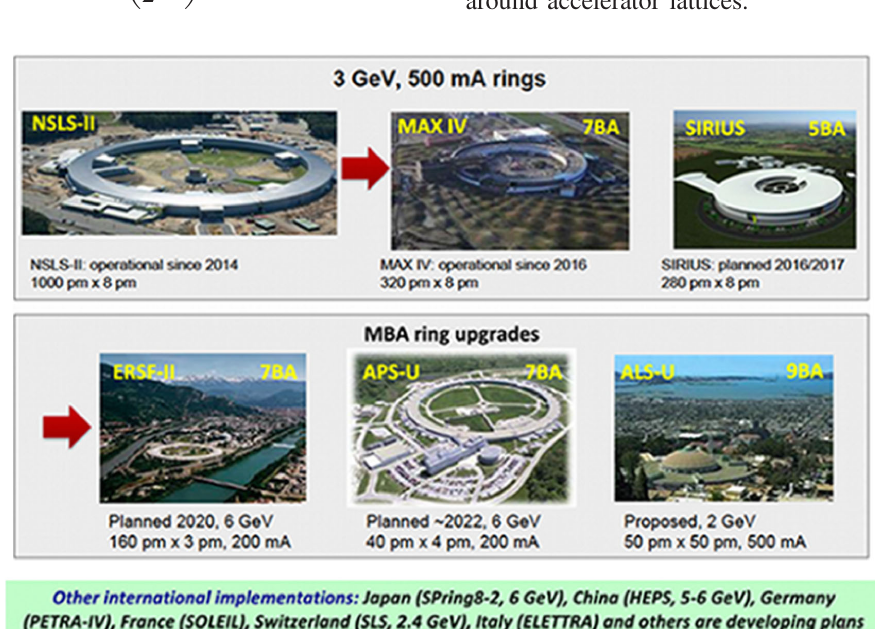
FIG. 4. Several post NSLS-II world advanced light sources implementing the new multibend achromat technology [28] (From MAX IV